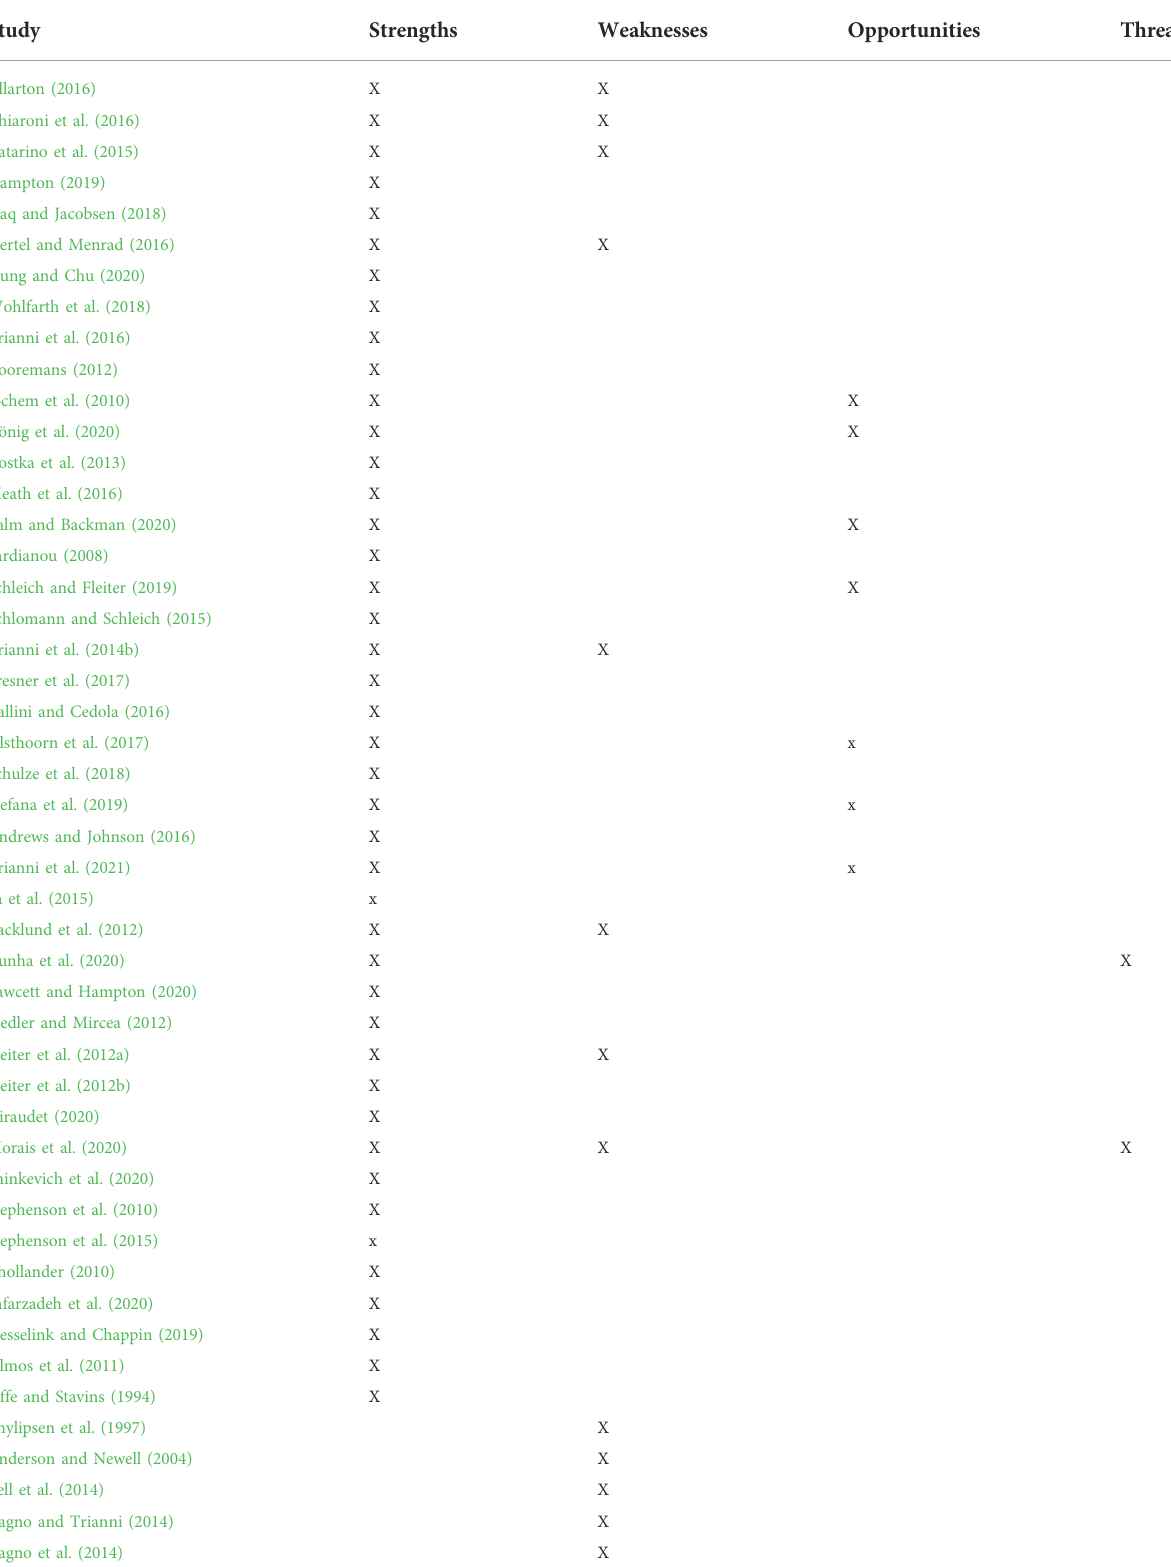
TABLE 7 Comprehensive SWOT-table of the studies